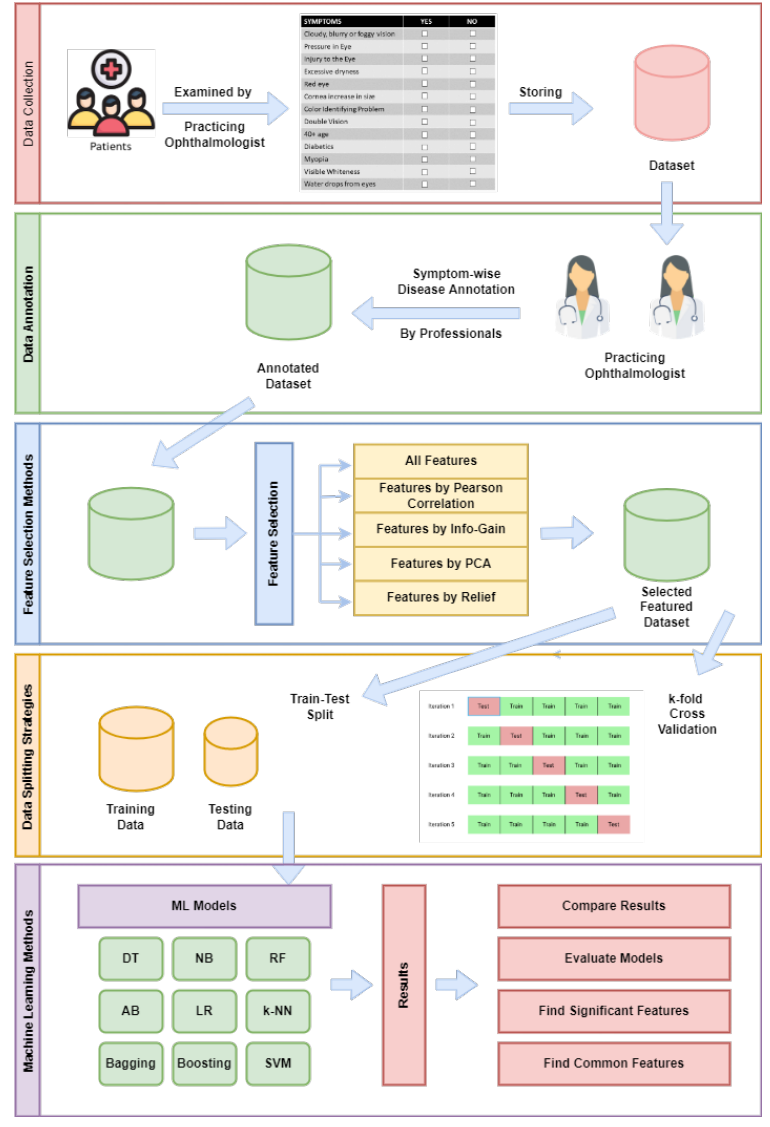
Figure 2. Overview of working diagram of the proposed eye disease prediction